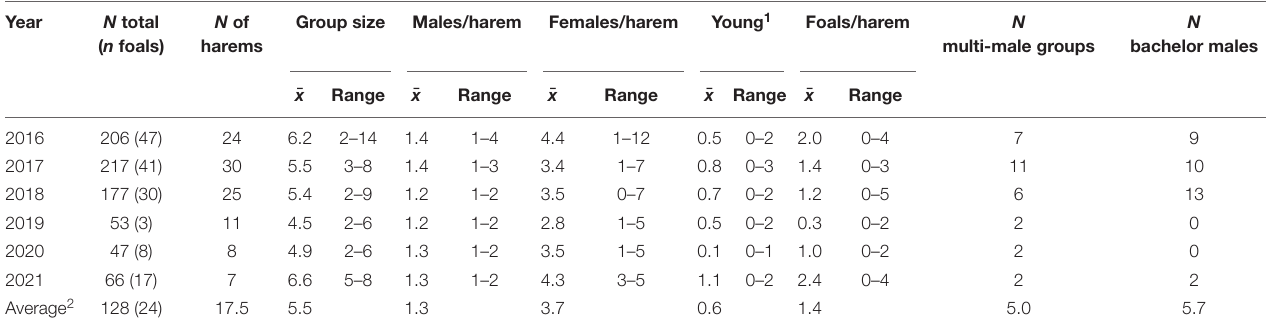
TABLE 1 | Group composition and size of the Garrano population in SA from 2016 to 2021, during breeding seasons. Year N total ( n